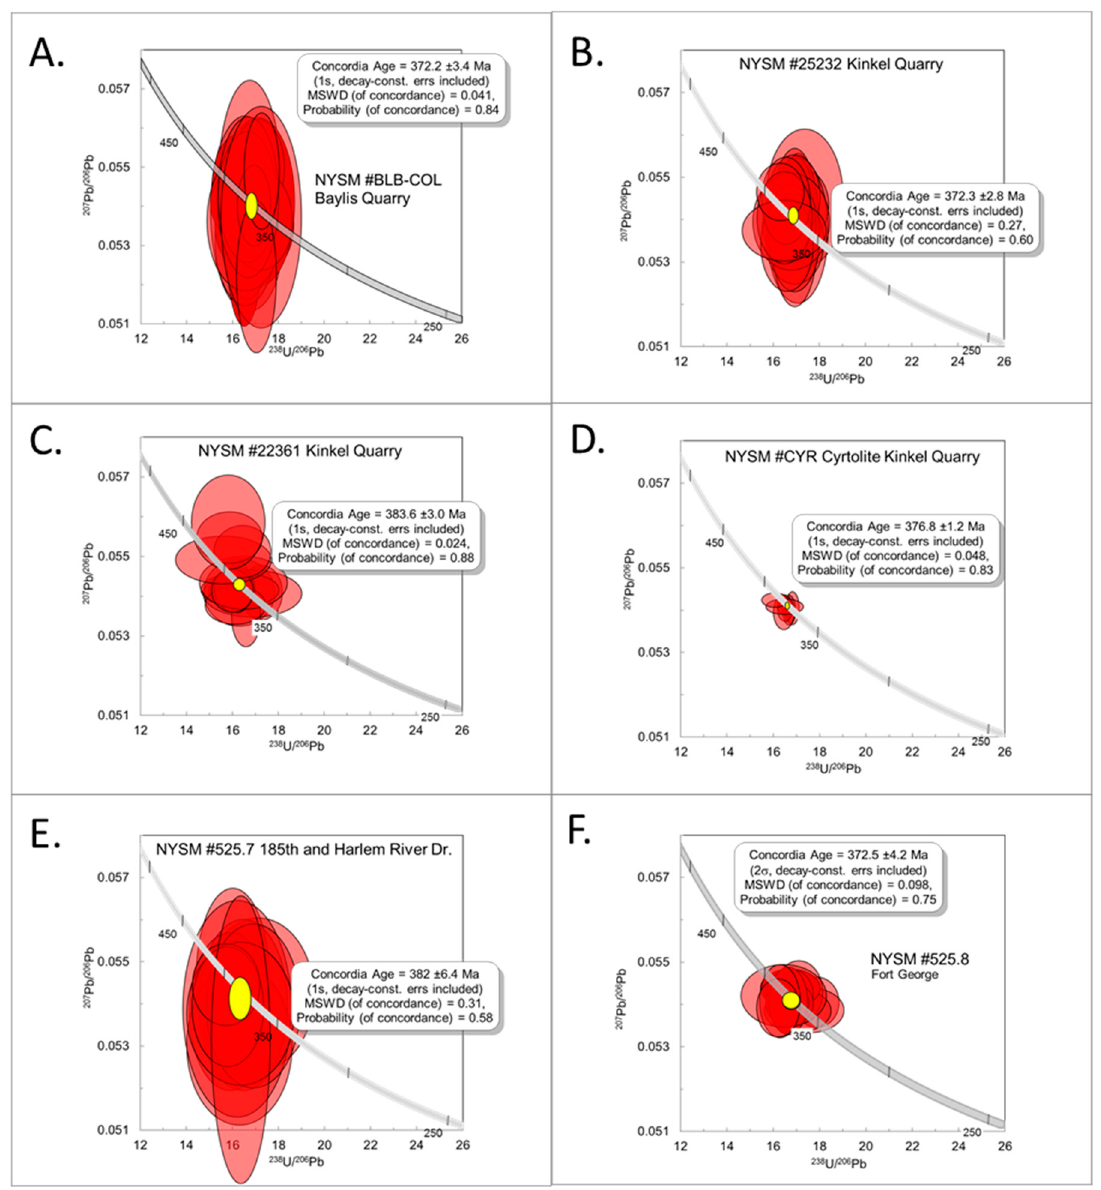
Figure 5. Tera-Wasserberg Concordia diagrams for columbite samples and cyrtolite analyzed during this study: ( A ) Baylis (NYSM #BCB-COL); ( B ) Kinkel (NYSM #25232); ( C ) Kinkel (NYSM #22361); ( D ) Kinkel (Cyrtolite); ( E ) Harlem River Drive (NYSM #525.7); and ( F ) Fort George (NYSM #525.8). All were analyzed by LA-MC-ICP-MS.